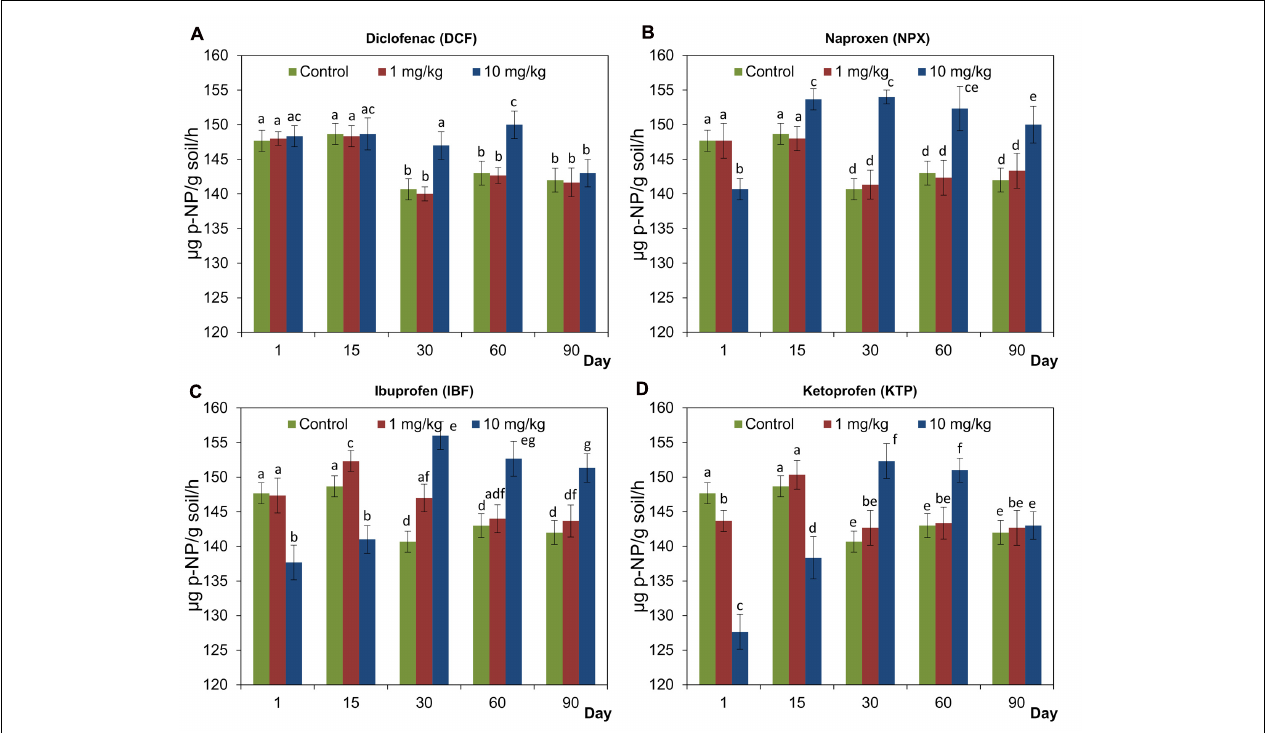
FIGURE 5 | Alkaline phosphatase (PHOS-OH) activity in control soil and soil treated with diclofenac (A) , naproxen (B) , ibuprofen (C) , and ketoprofen (D) at concentrations of 1 and 10 mg/kg soil during the 90-day experiment. The data presented are the means and standard deviations of three replicates and are expressed as µ g p -NP/g soil/h. Different letters (within each drug) indicate significant differences ( P < 0.005, LSD test) related to the effects of concentration and time.